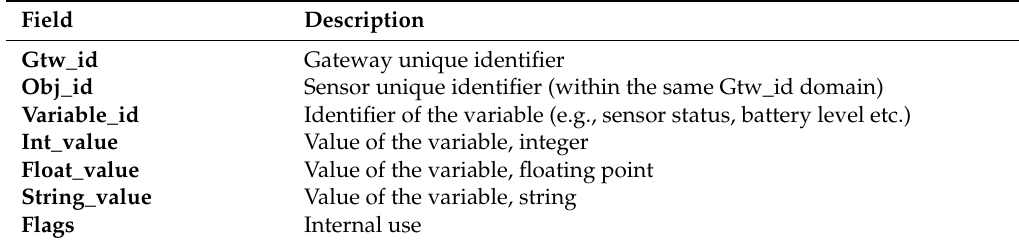
Table 1. SQL database